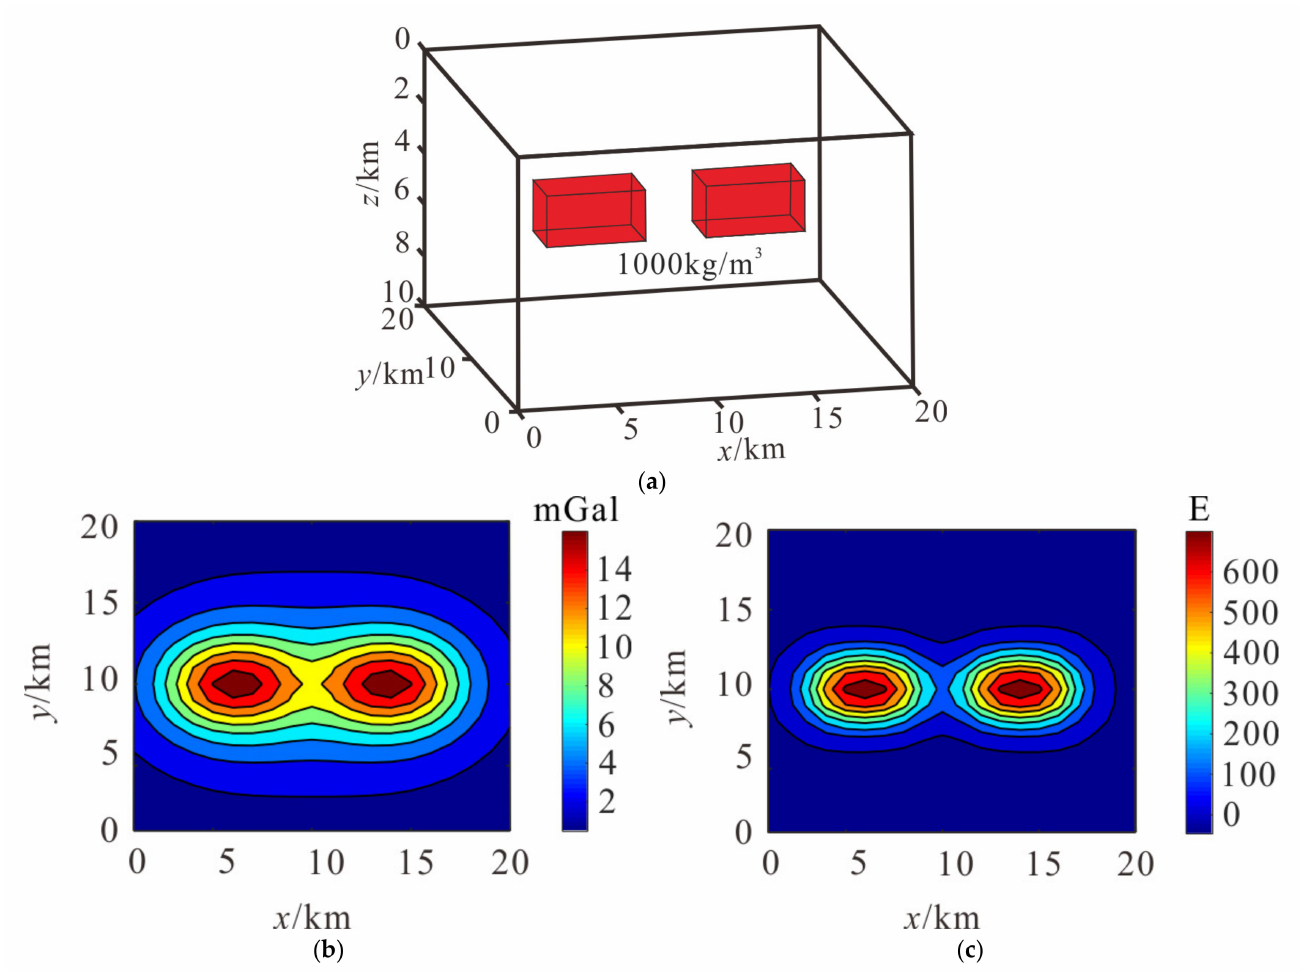
Figure 6. Information of models in the same depth. ( a ) Density models with 1 kg/m 3 . ( b ) Airborne gravity anomaly at 100 m altitude. ( c ) Vertical gradient anomaly of airborne gravity data at 100 m